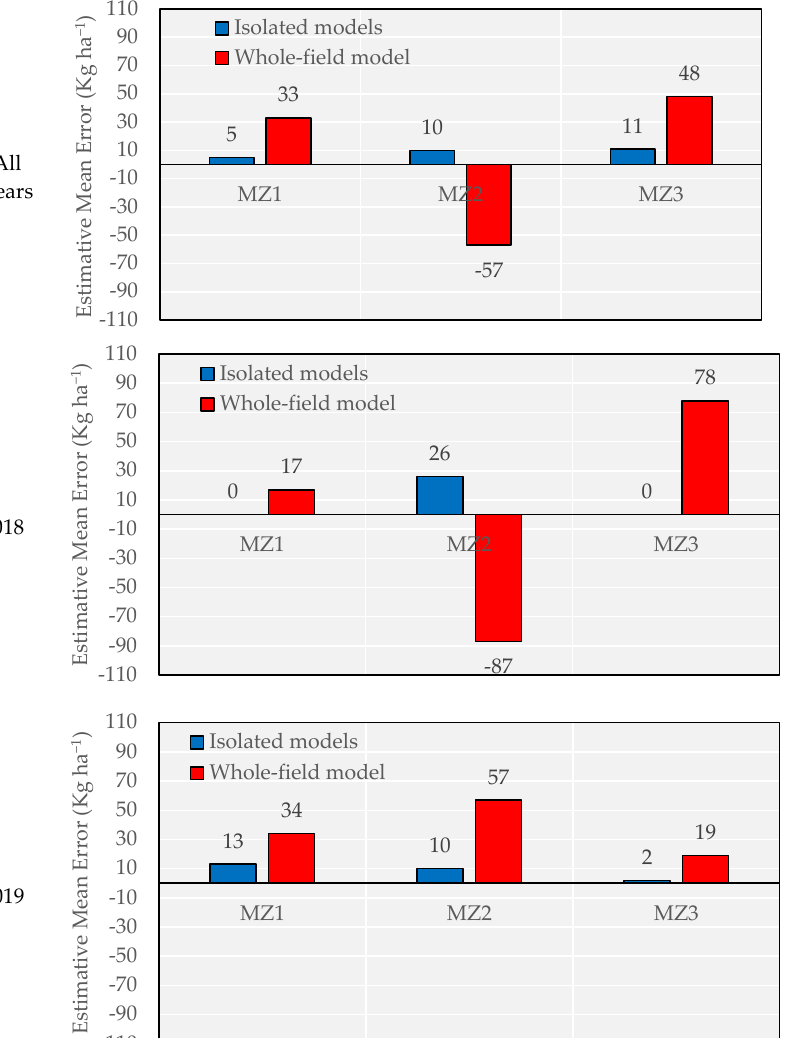
Figure 11. Comparison between the tendency of the whole-field model and specific models for each management zone in three scenarios (all years combined, 2018 and 2019 season). MZ1, MZ2, and MZ3: management zones one (high yield), two (low yield), and three (intermediate yield), respec- tively.